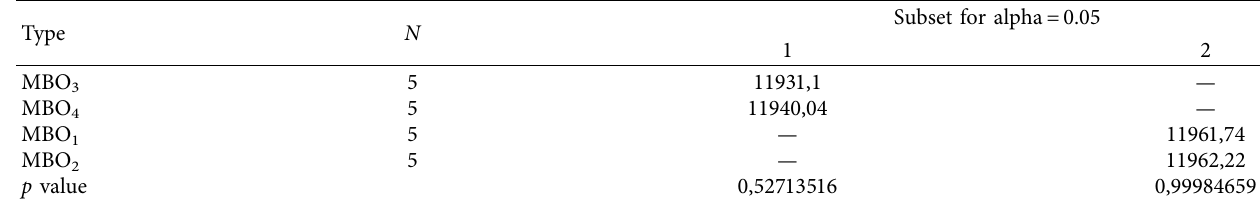
Table 13: Tukey’s test for the fl417